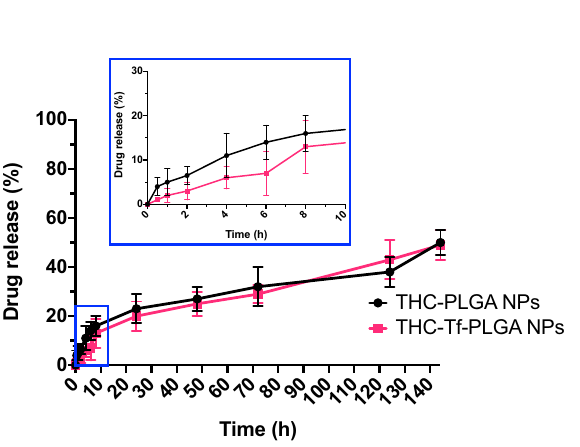
Figure 1. SEM images of ( a ) THC-PLGA-NPs and ( b ) Tf-THC-PLGA NPs.